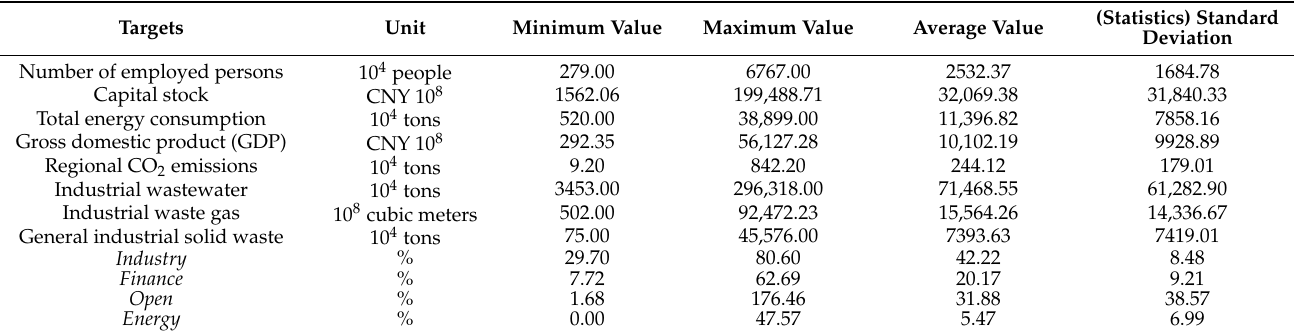
Table 1. Definitions and descriptive statistics for each